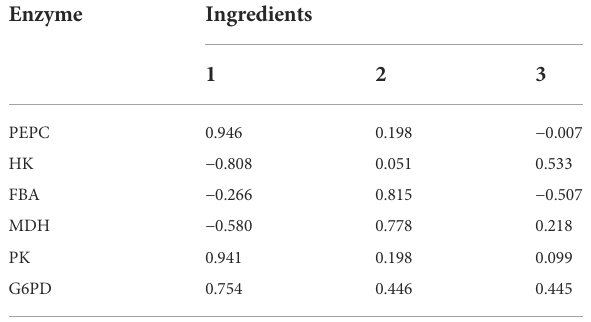
TABLE 4 Matrix of principal components.